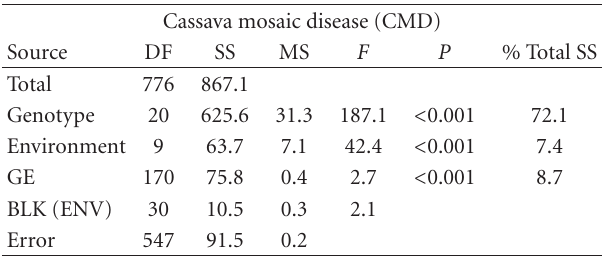
Table 3: Combined analysis of variance table of genotype, envi- ronment, and genotype by environment contributions to the sum of squares of fresh root yield of 21 yellow-fleshed genotypes in 10